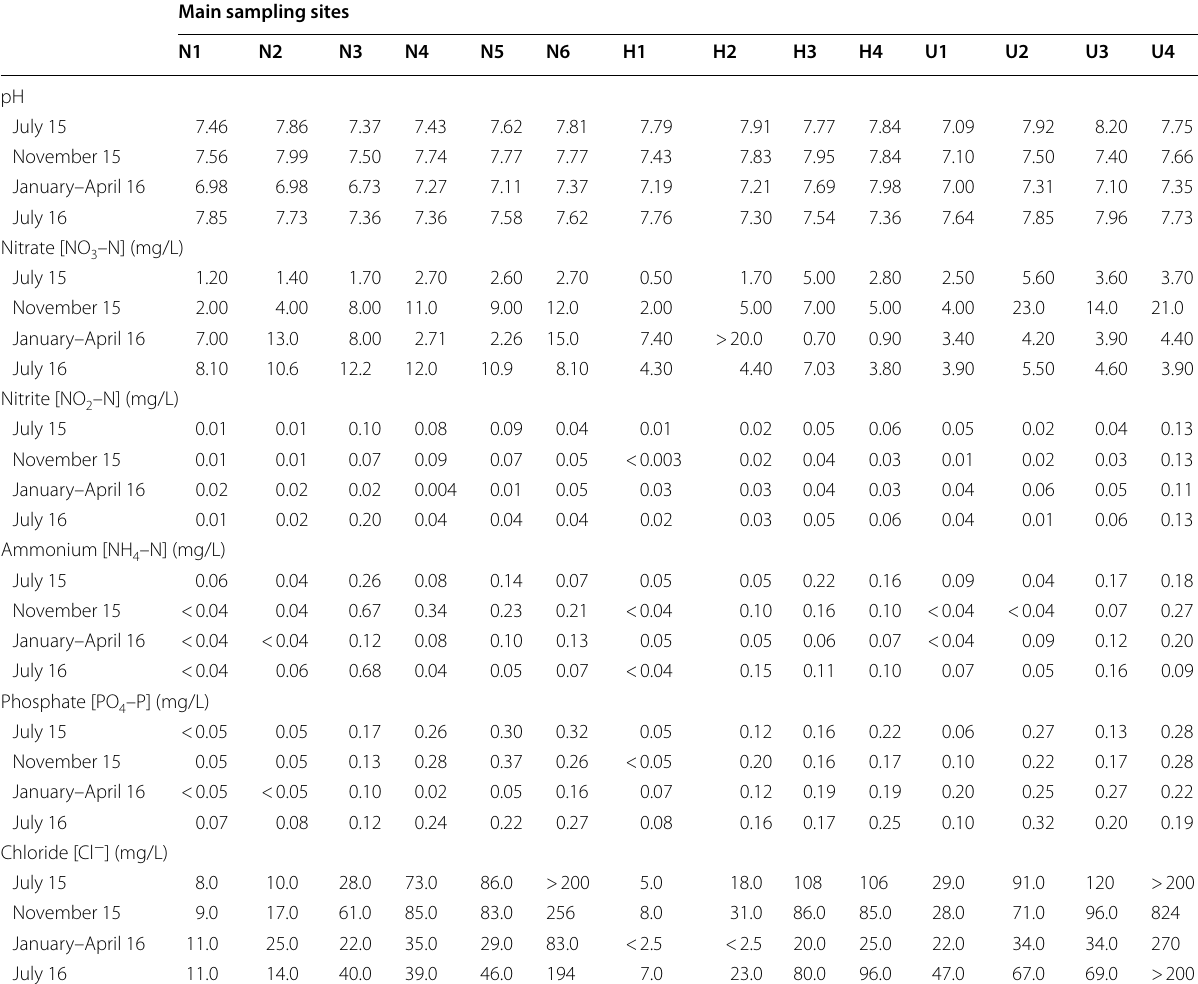
Table 6 Physicochemical parameters measured at the main sampling sites at the time of sampling